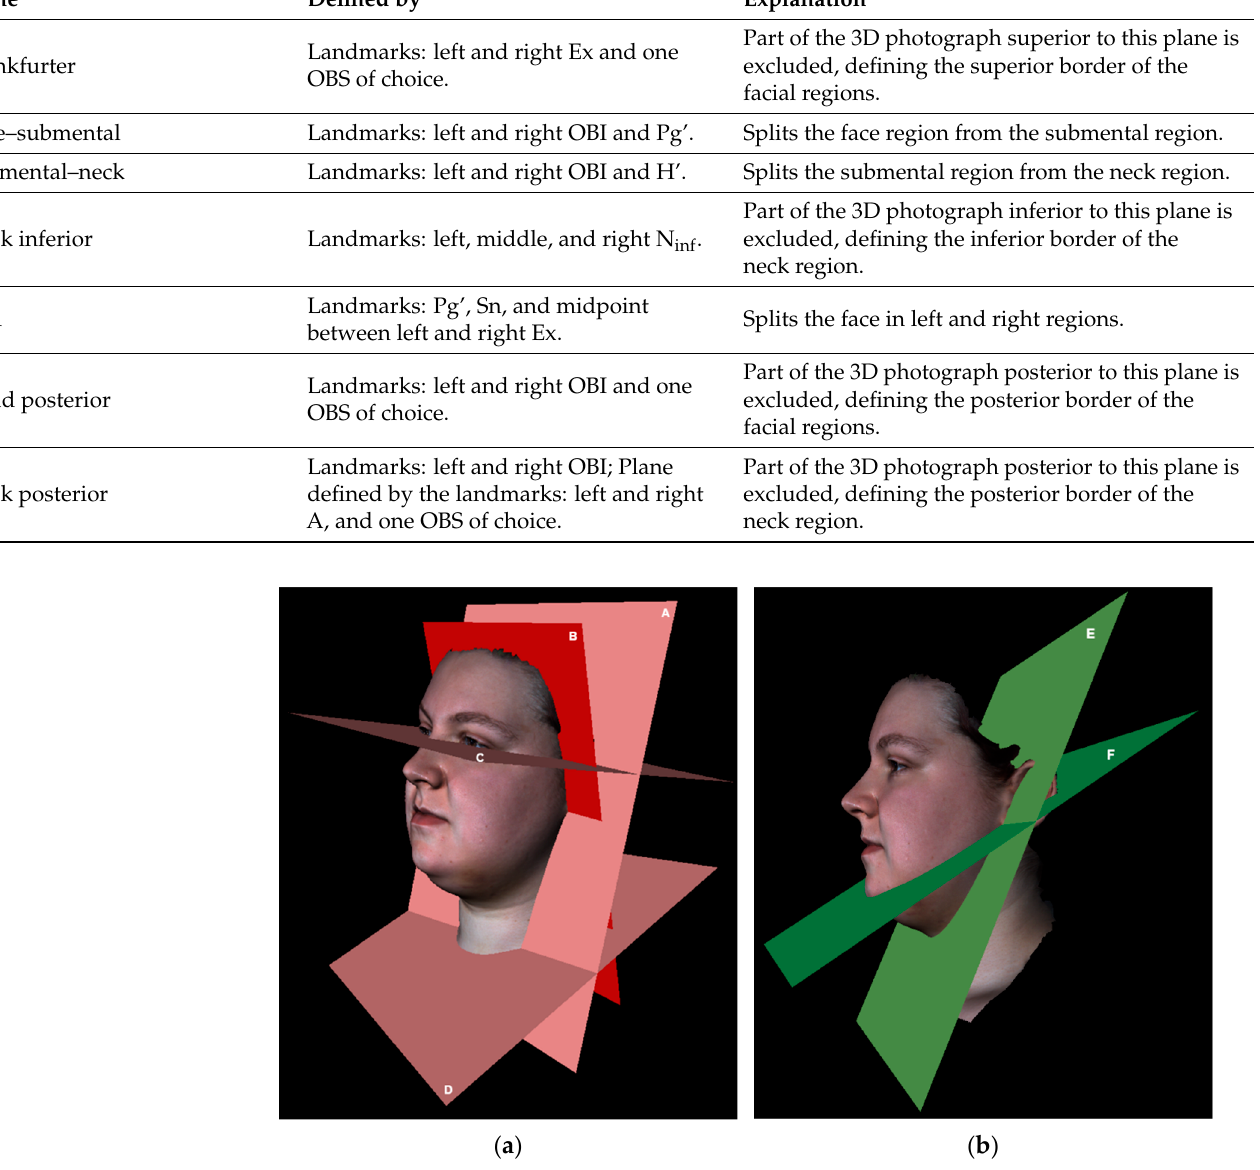
Figure 3. Examples of the planes for splitting 3D photographs into right face, left face, submental, and neck regions. ( a ) A: Neck posterior plane; B: head posterior plane; C: Frankfurter plane; D: neck inferior plane; ( b ) E: face–submental plane; F: submental–neck plane (Mid plane is not